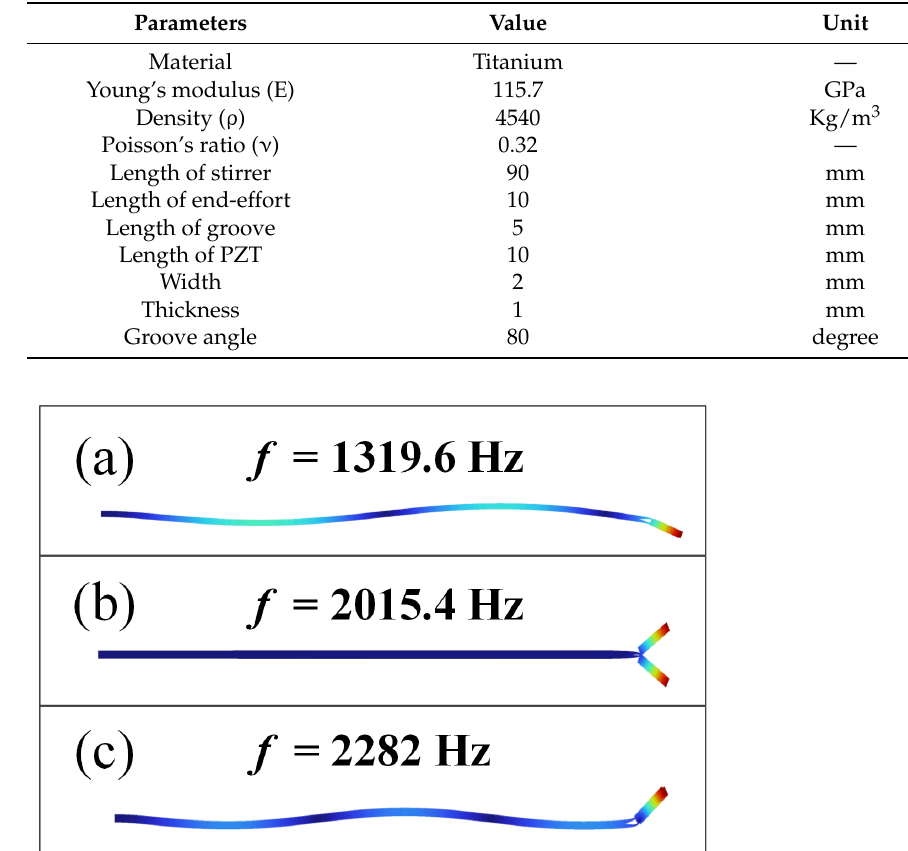
Table 1. Parameters of FEM model.